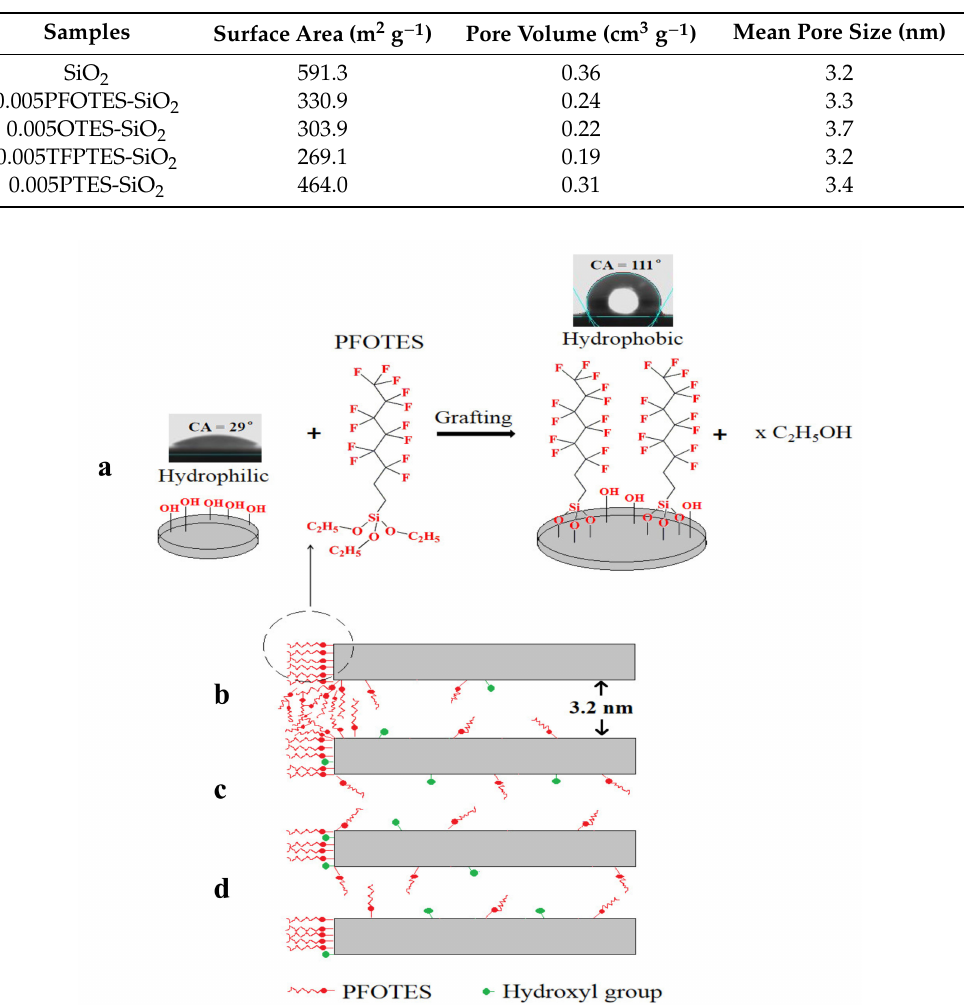
Figure 8. The surface silylation process and its e ff ect on the pore structure of silica membranes. ( a ) external surface; ( b ) entrance surface; ( c , d ) internal